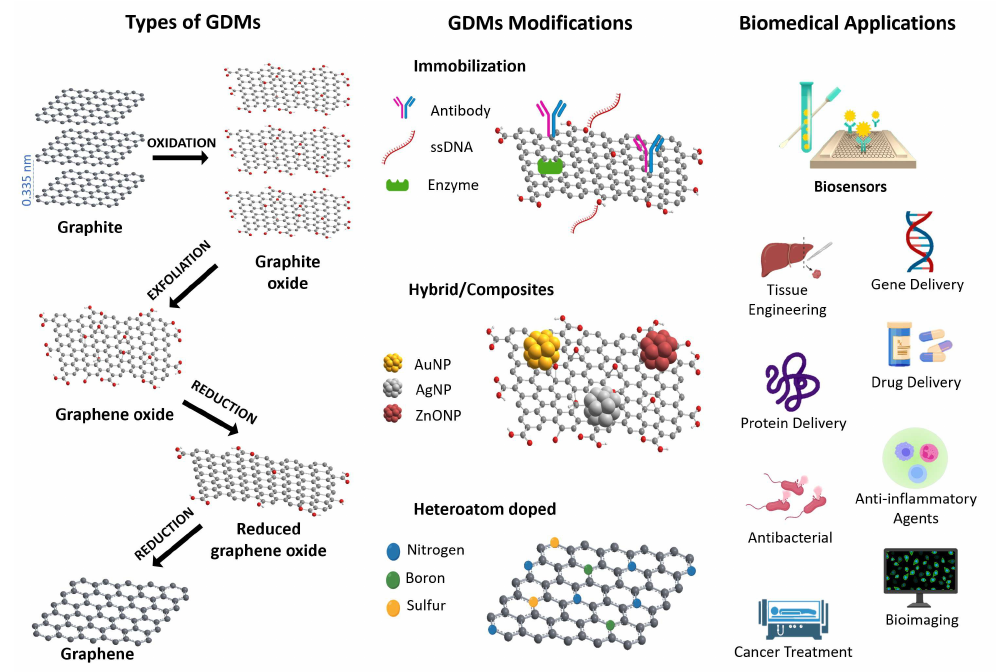
Figure 1. Schematic representation for the types of GDMs and route of graphite to graphene, its modifications, and potential applications in several research